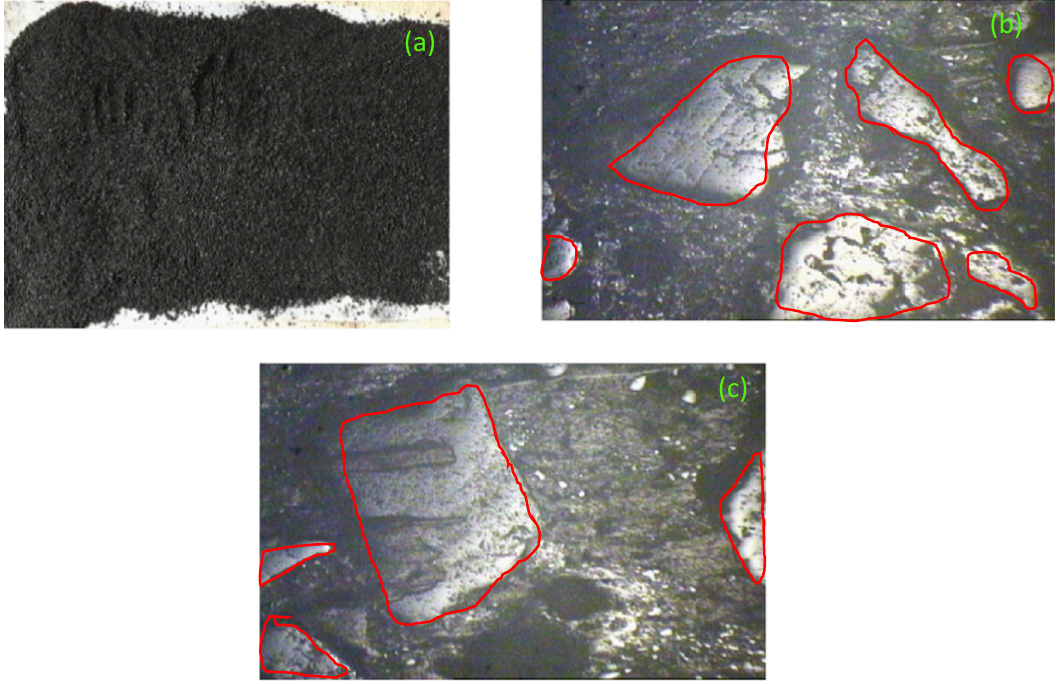
Figure 3: Photos of MCNT - coated sand in: ( a ) naked scale; ( b ) and ( c ) optical scale (× 200 magni fi cation ) ( red polygons – island - like sand surface surrounded with CNT/SA latex ) .